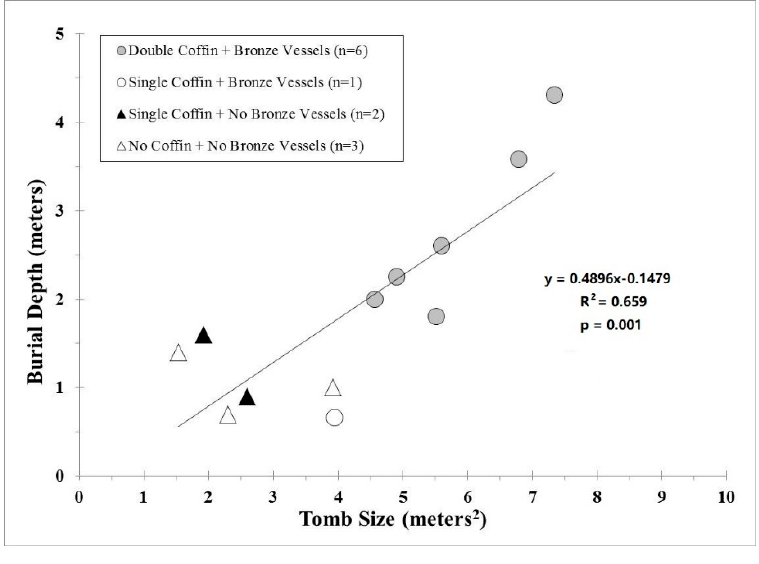
Figure 4. Plot of burial depth (m) vs. tomb size (m 2 ) for individuals buried in different coffin types with and without bronze funerary vessels at the Xiaohucun site, Henan Province, China. Table 4. Classification of social status for burials from the Shang and Zhou Dynasties. Note: Information is referenced from IA CASS [3].